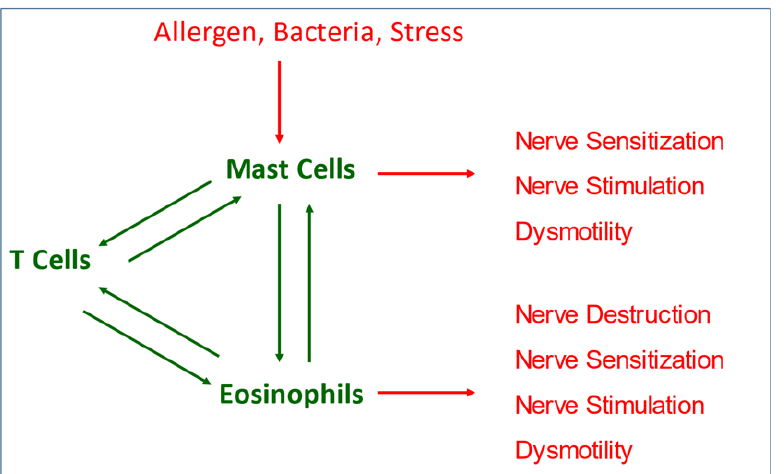
Figure 2. Within FAPD pathophysiology, particularly related to allergy, there are several therapeutic targets, including factors that stimulate or enhance an immunologic response, factors related to inflammatory cell infiltration or activation, or downstream effects following mediator release, either blocking receptors for released mediators or counteracting the physiologic effects of these mediators.